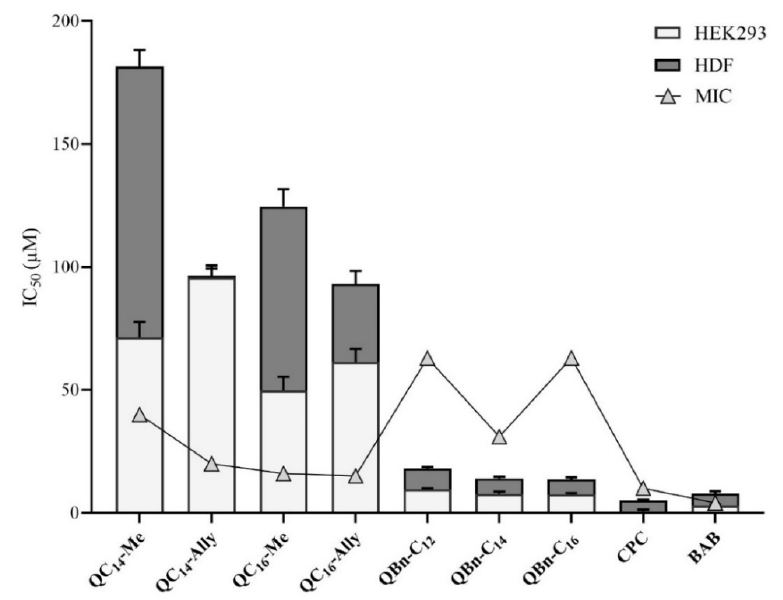
Figure 6. Cytotoxicity of 3-amidoquinuclidine quaternary ammonium compounds (QACs) and commercial QACs, cetylpiridinium chloride (CPC), and benzyldodecyldimethylammonium bromide (BAB). The IC 50 values obtained are given as bars in μ M values and compared to MIC against Staphylococcus aureus ATCC 25923 (line).